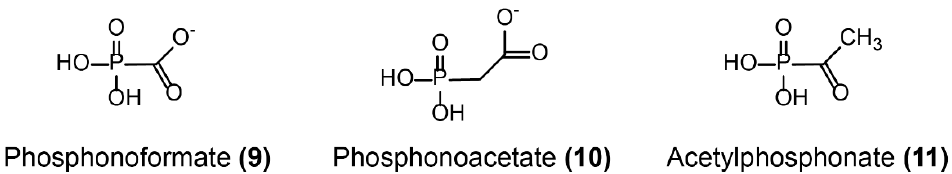
Figure 10. Inhibitors of the fosfomycin ‐ resistance enzyme FosA.